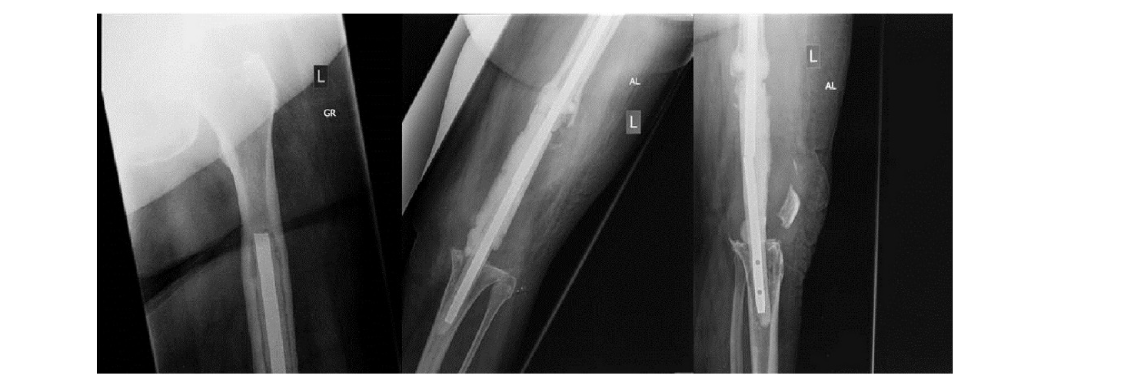
Figure 6: Treatment of the infected tumor prosthesis from Figure 5, consisting of prosthesis explantation and spacer implantation. Due to the large bone defect, an overbridge to maintain leg length and stability was required. Here, an antibiotic-loaded cement-coated nail was implanted with a cement spacer in the leg to solve this